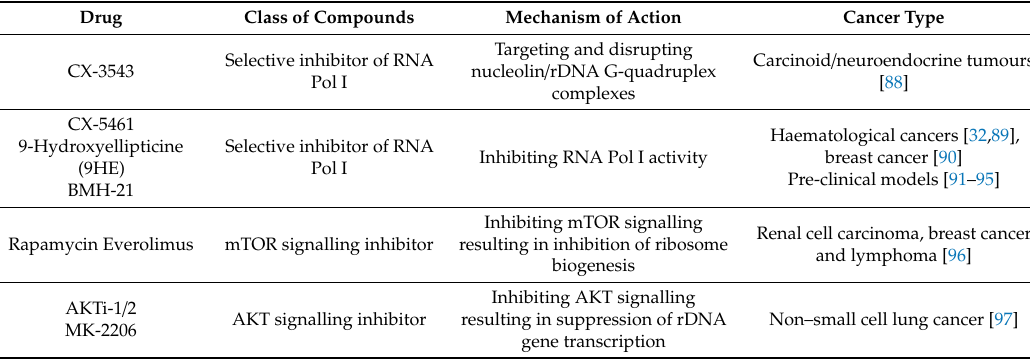
Table 2. Classification of Compounds selectively targeting Nucleolar Functions in